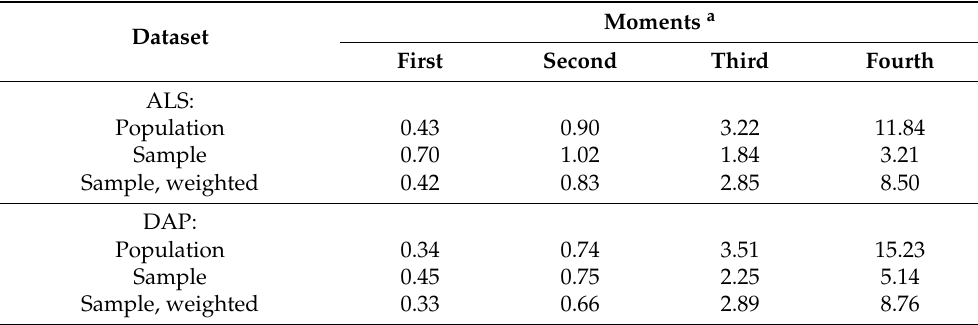
Figure 5. Distributions of h max in the population ( N = 79,242) and the sample with and without weighting of the sample observations ( n = 716) for the two different 3D remotely sensed datasets. Table 6. The first four moments of the distributions of h max in the population ( N = 79,242) and in the sample ( n = 716) for the two different 3D remotely sensed